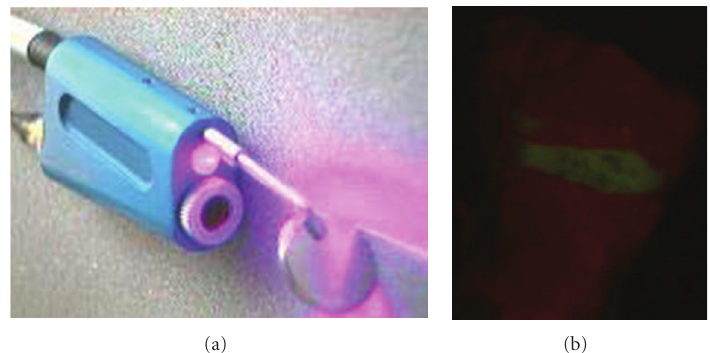
Figure 2: Fluorescent tooth image (b) collected by Quantitative Light-induced fluorescence [QLF] (a).